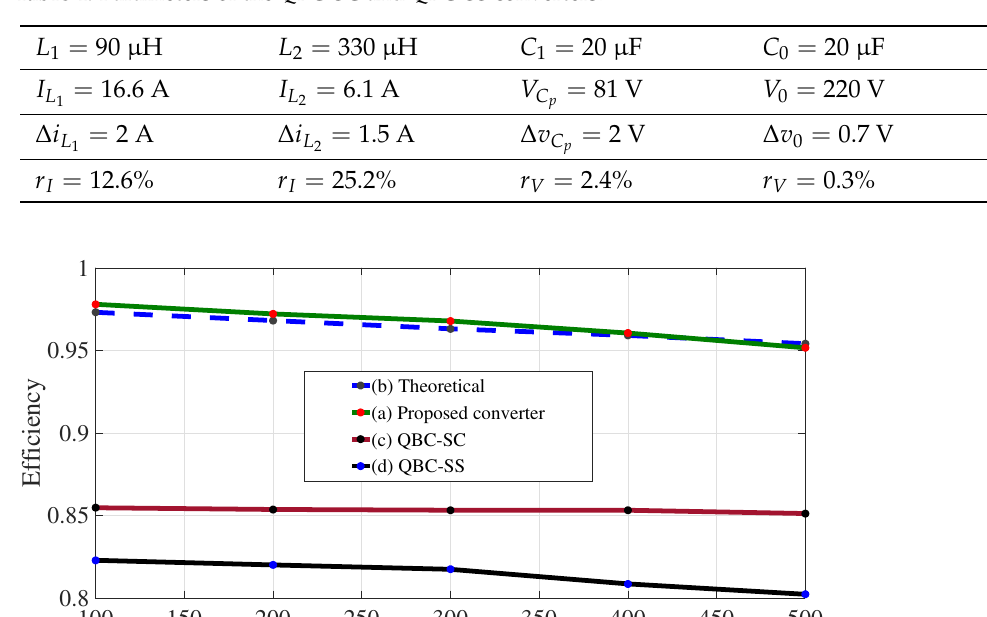
Figure 16. Circuit of the QBC-SS prototype for the experimental efficiency comparison with the proposed converter. Table 4. Parameters of the QBC-SC and QBC-SS converters.